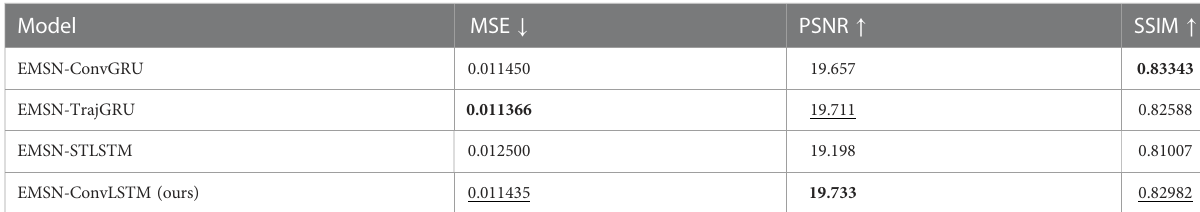
TABLE 5 Results of EMSN with different RNN variations. The best result is marked in bold; the second-best result is underlined. Model